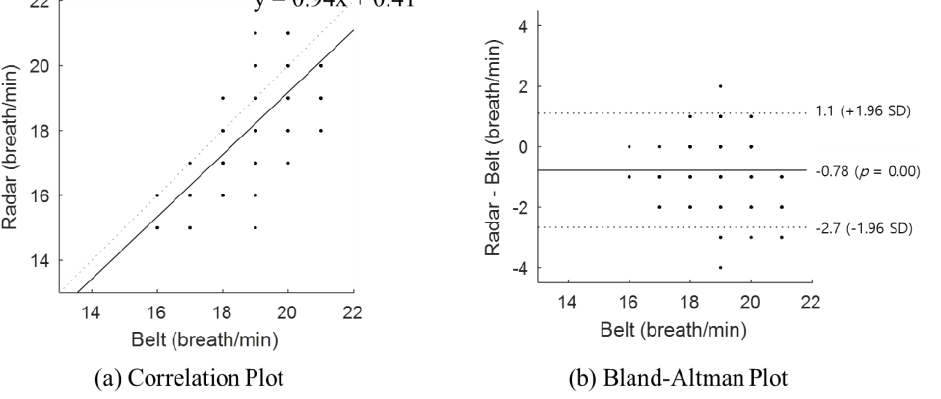
Figure 5. Statistical evaluation of the radar sensor according to all subjects: ( a ) correlation plot and ( b ) Bland–Altman plot.